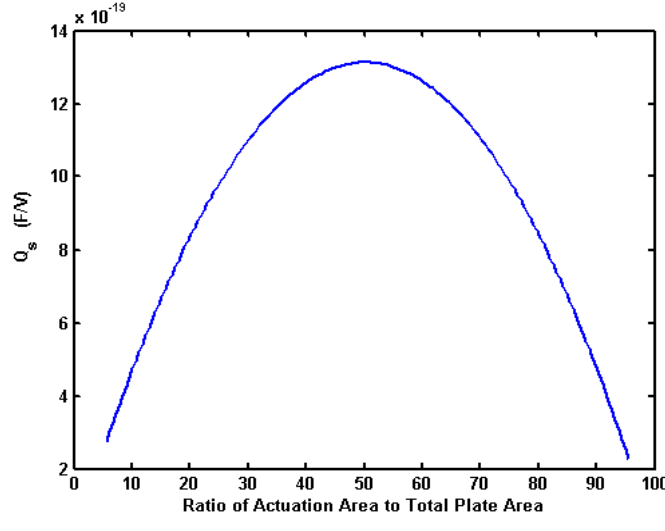
Figure 20. Effect of the actuation area on sensitivity for 200 μ m × 200 μ m × 3 μ m plate, = 10 V, g = 4 μ m, P = 101,000 Pa, k with V o o a 149 μ m × 149 μ